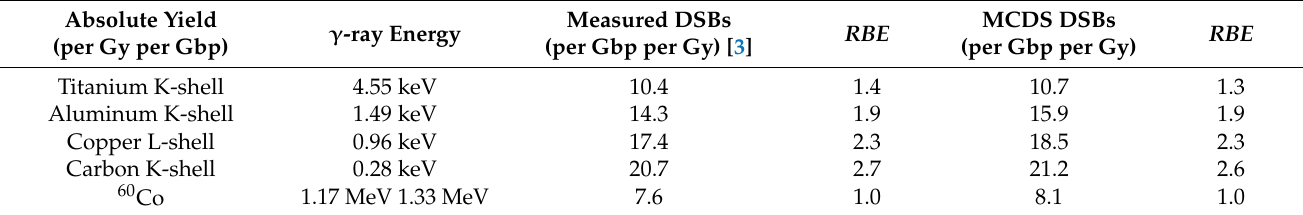
DSBs, double-strand breaks; MCDS, Monte Carlo damage simulation; RBE , relative biological